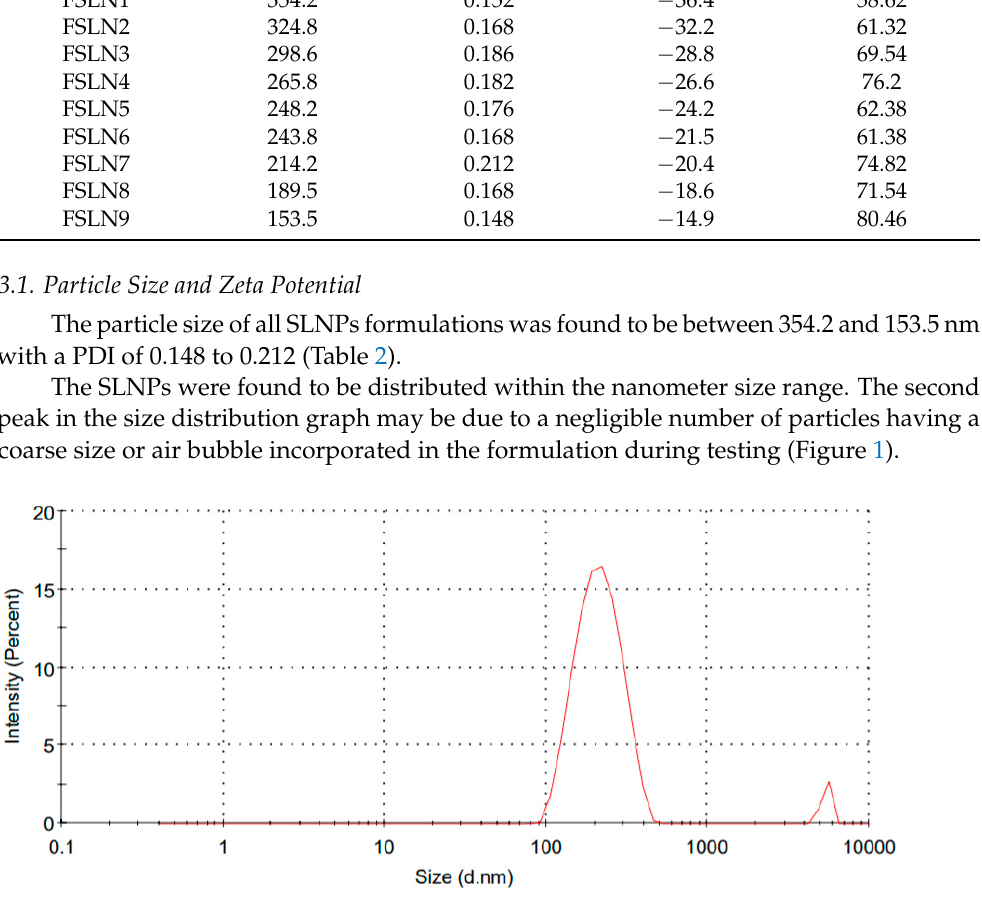
Figure 1. Size distribution study of formulation FSLN9.